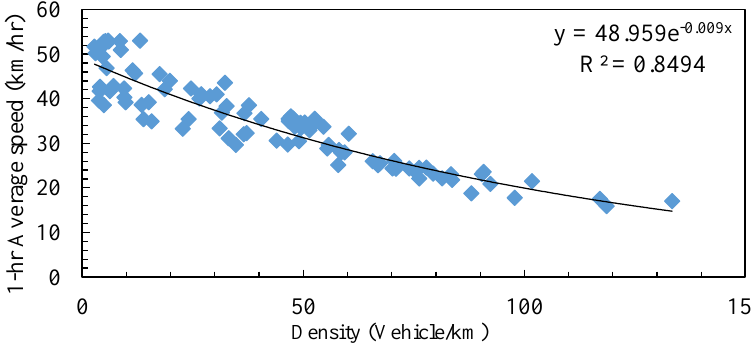
Figure 6. Traffic models of the 3-lane road with more samples.